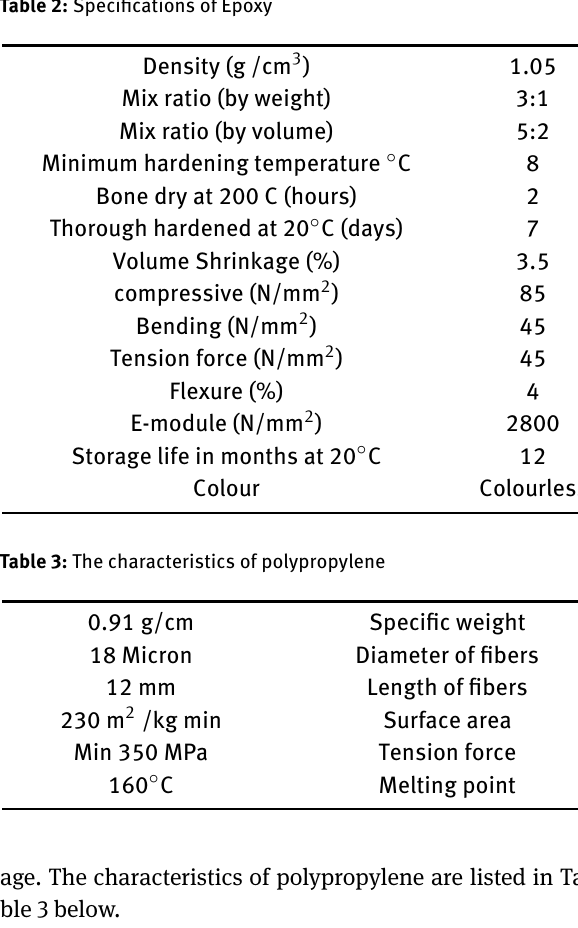
Table 2: Specifications of Epoxy